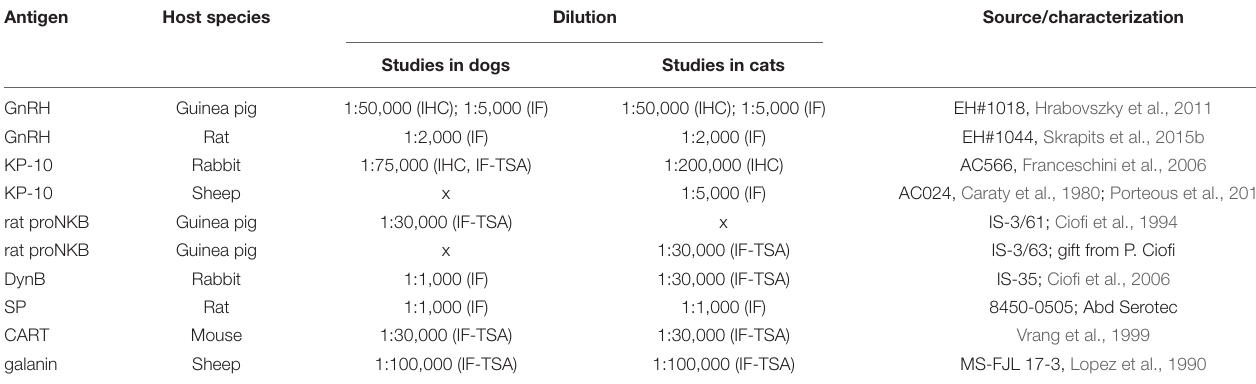
TABLE 2 | Specification, source and dilution of primary antibodies used in immunohistochemical and immunofluorescence experiments. Antigen Host species